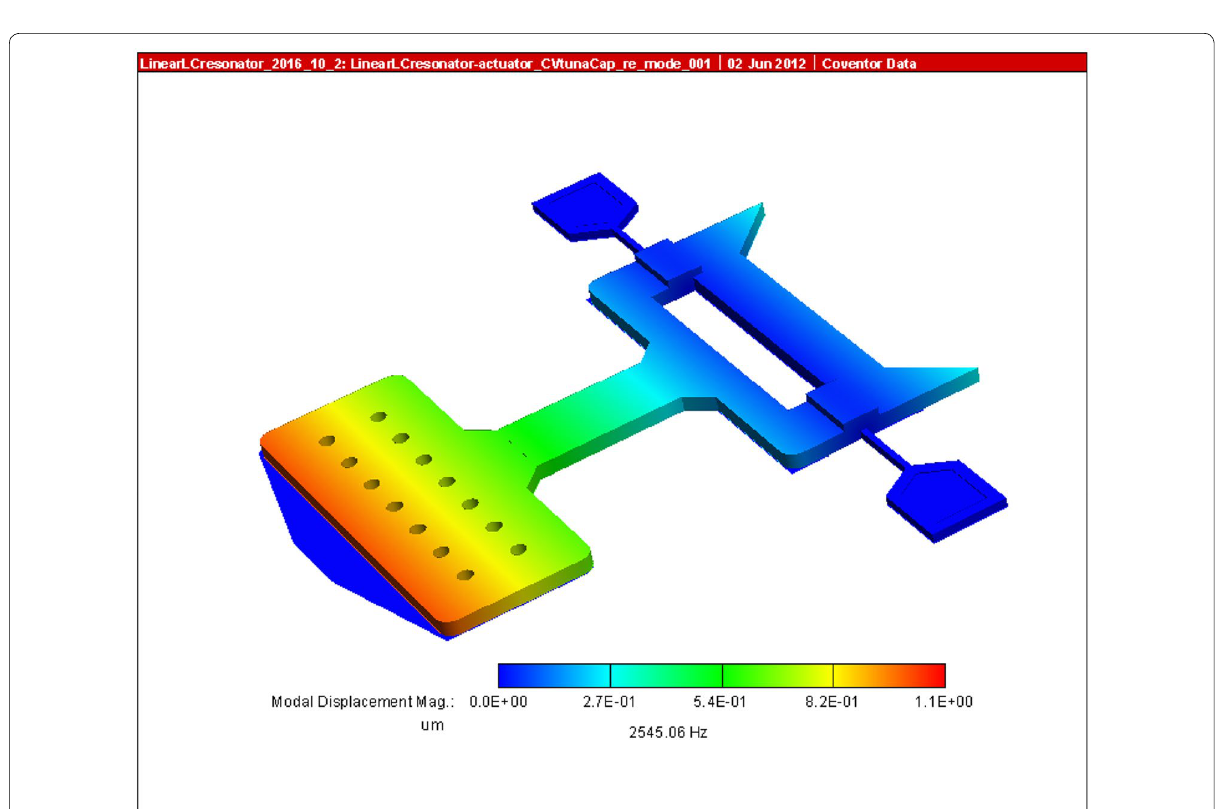
Fig. 10 CoventorWare ™ simulation result of mechanical resonance. It occurs at 2.545 kHz